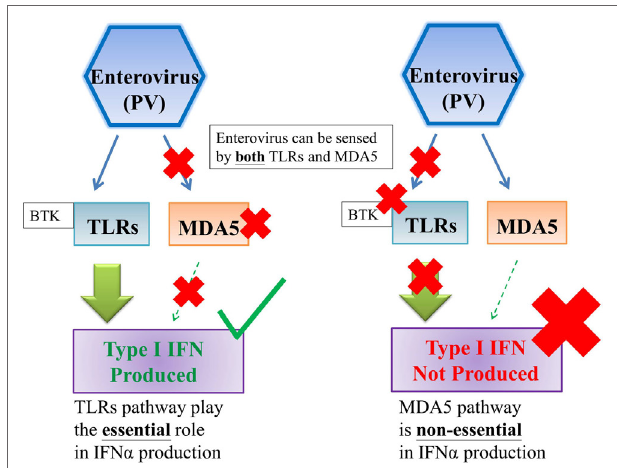
FigUre 1 | TLRs pathway, but not MDA5 pathway, is essential to the production of type I interferon against enterovirus infections. Enterovirus can be sensed by both TLRs and MDA5; however, TLRs pathway, but not MDA5 pathway, plays the essential role on type I interferon production against enterovirus infections (2). Abbreviations: PV, poliovirus; TLRs, toll-like receptors; MDA5, melanoma differentiation-associated protein 5; IFN,